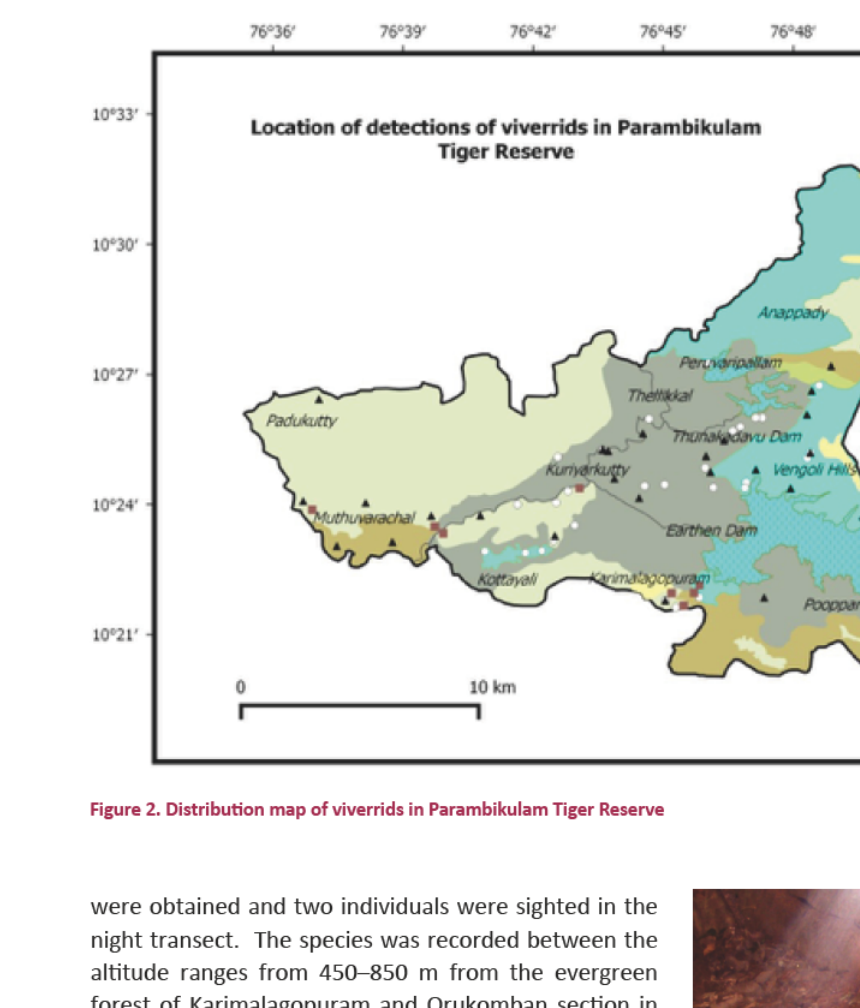
Ffigure 2. Dfistrfibufion map off vfiverrfids fin Parambfikulam Tfiger